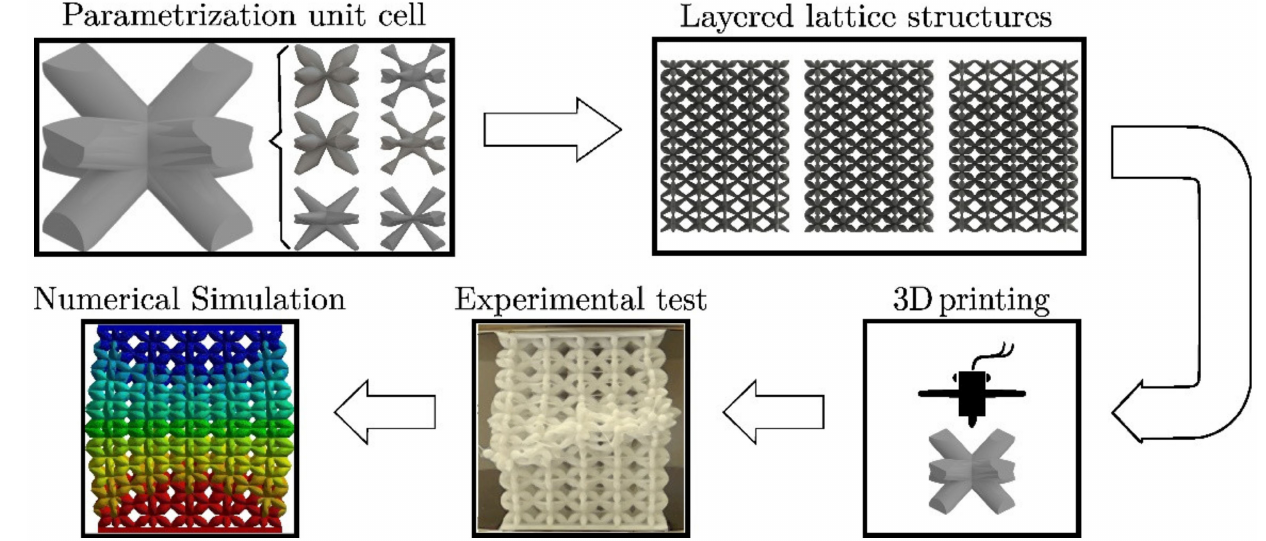
Figure 1. The methodology followed: parametrization of the unit cell, design of layered lattice structures (LLS), 3D printing, experimental test, and numerical